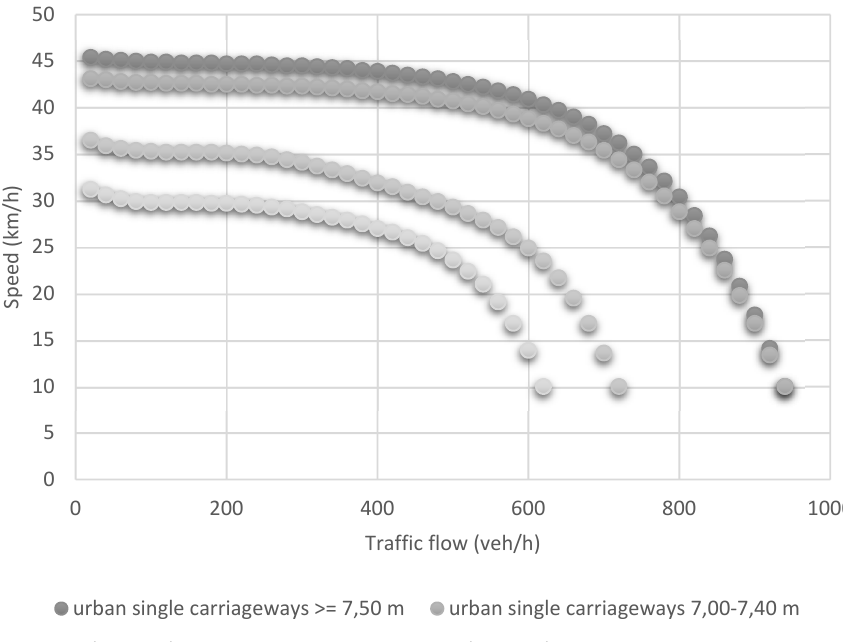
Figure 3. Speed-traffic flow curves for urban single carriageways. Source: Adapted from “Instruction for assessing the economic efficiency of road and bridge projects 2008”.